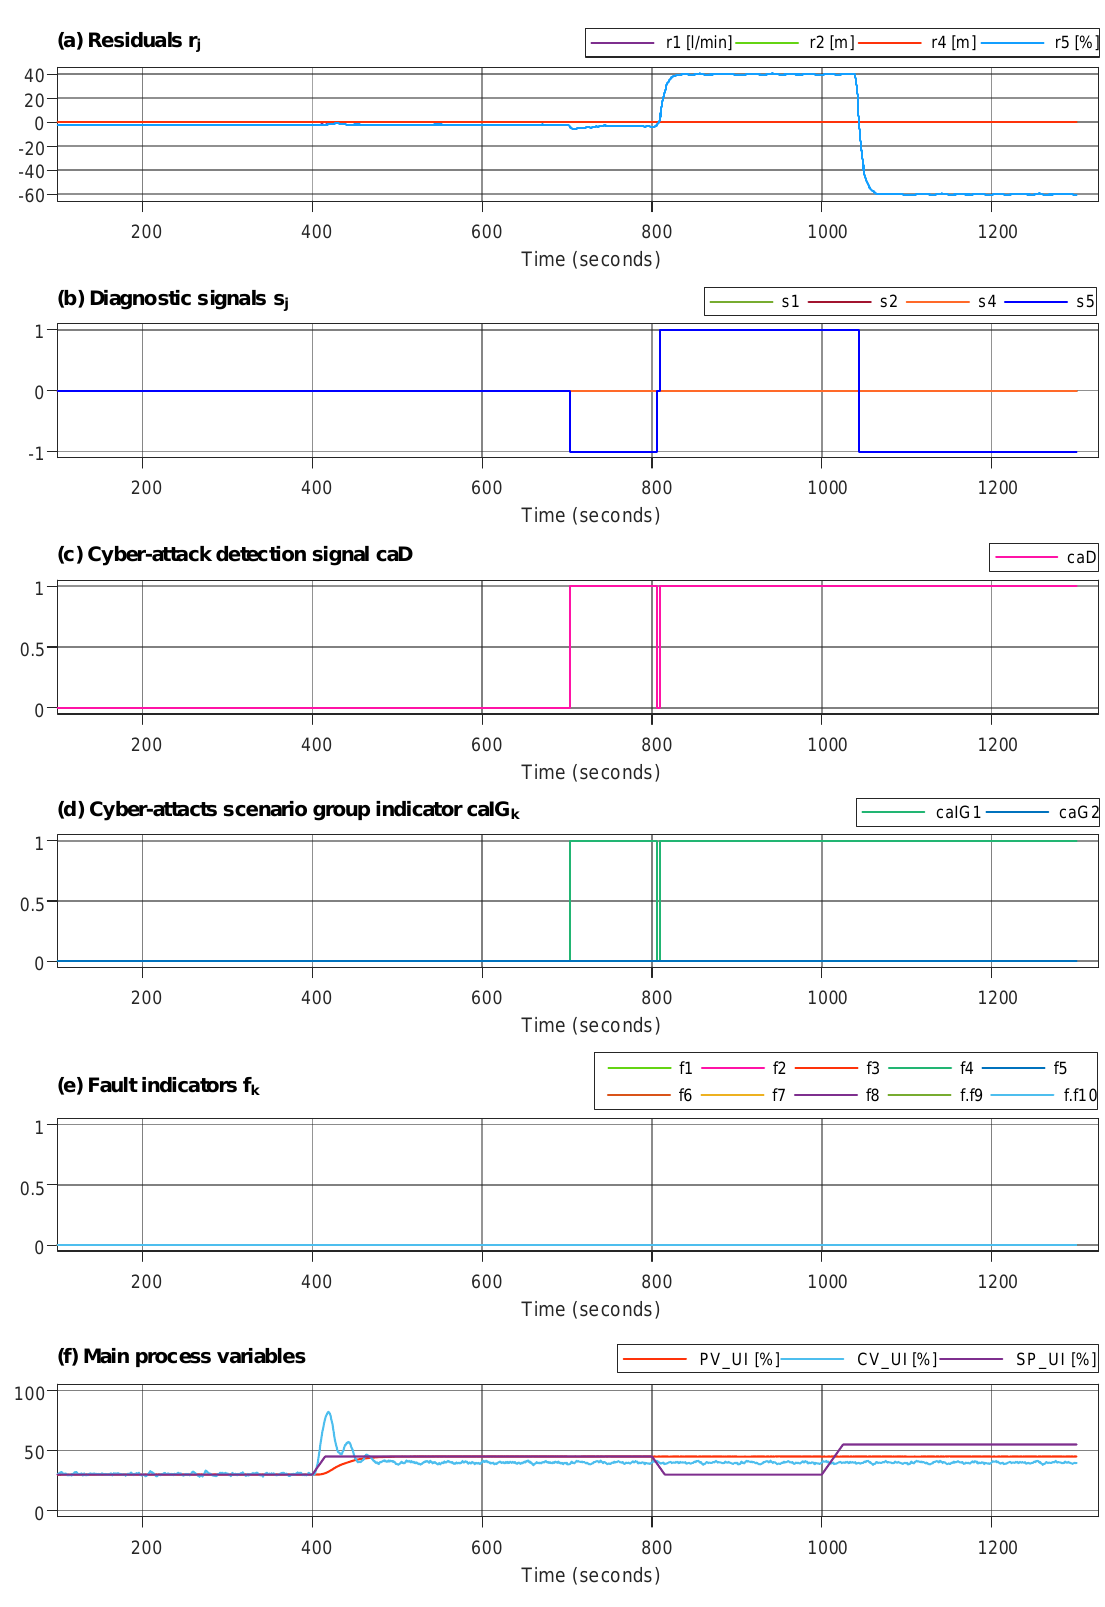
Figure 4. An example of the detection of a cyber-attack cas B : ( a ) values of residuals (signals r 1 , r 2 and 1 r 4 overlap), ( b ) values of diagnostic signals (signals s 1 , s 2 and s 4 overlap), ( c ) signal of cyber-attack detection, ( d ) indicators of location of groups of cyber-attack scenarios, ( e ) indicators of process failures (all signals overlap and have the value of ‘0’), ( f ) main process